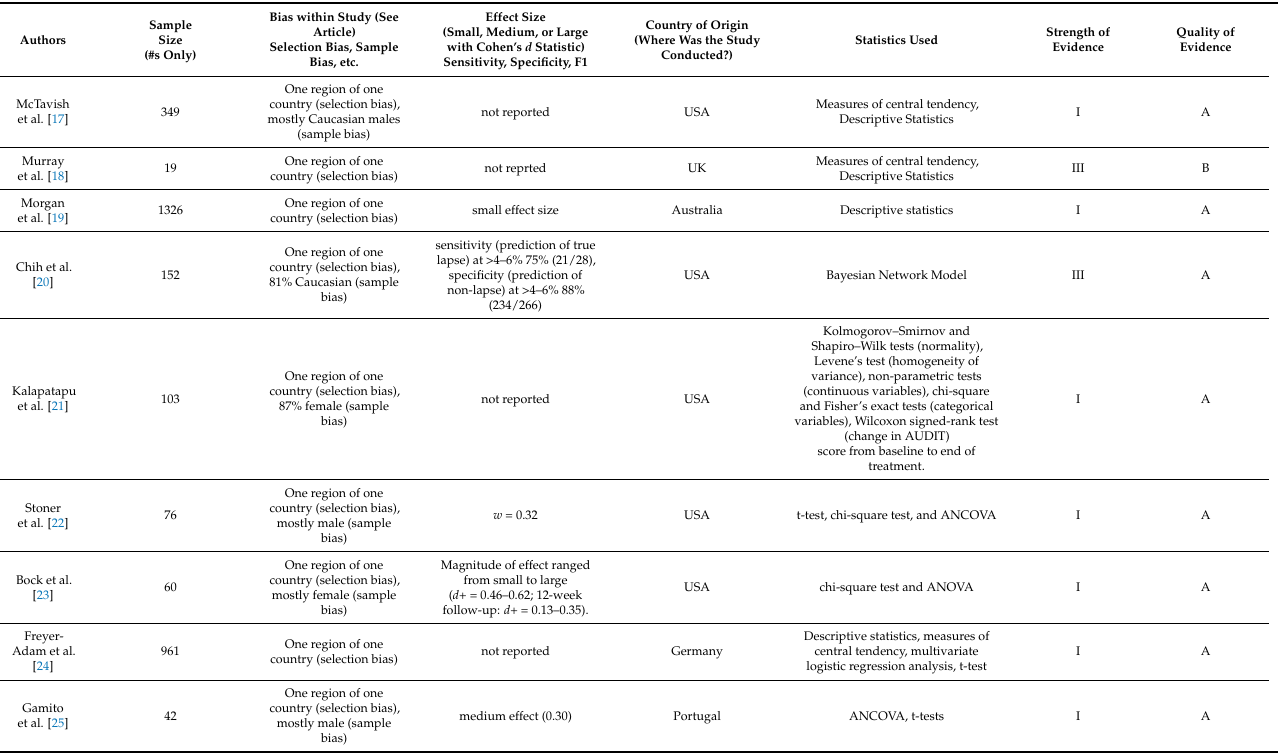
Table A3. Other observations incident to